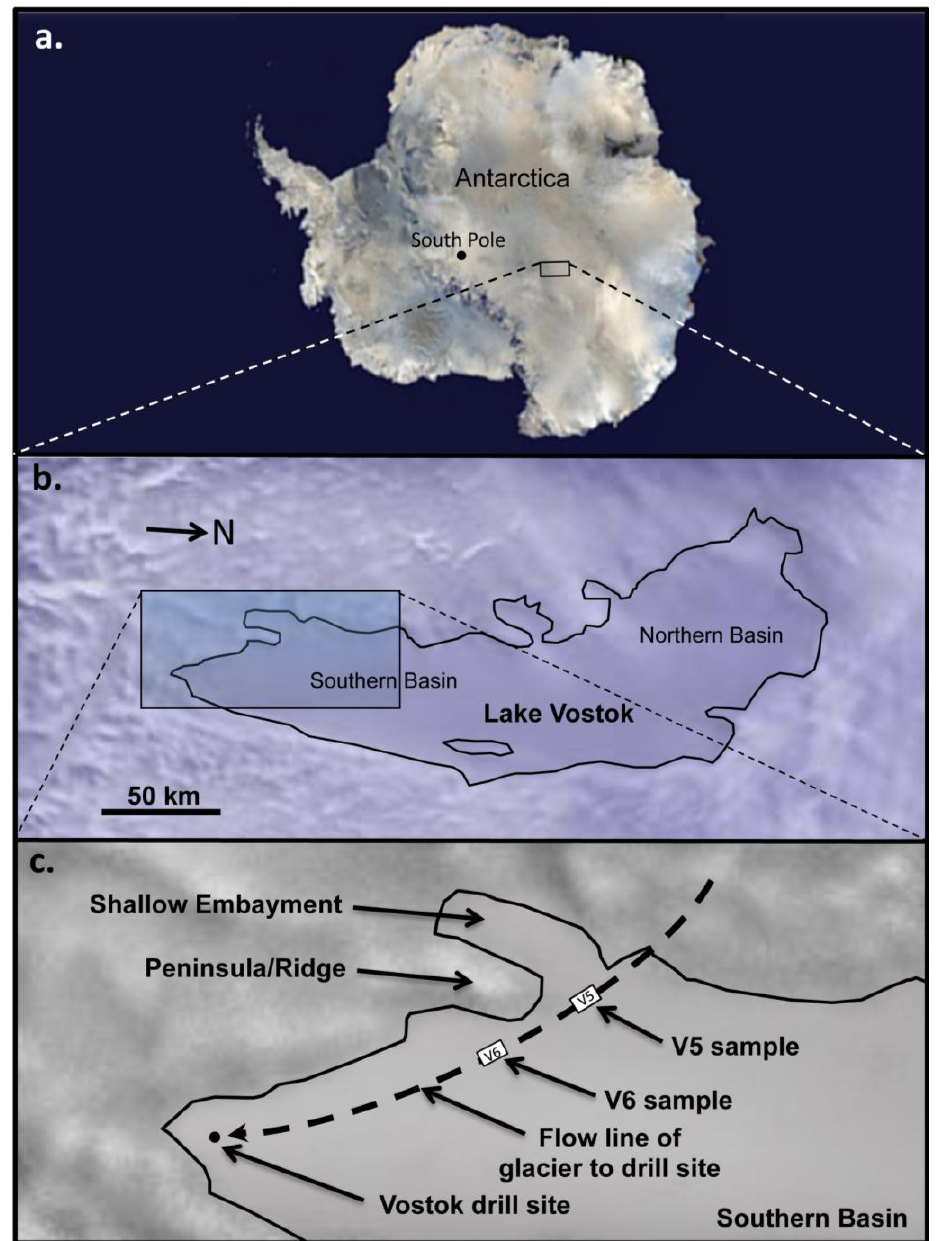
Figure 1. Source of ice core sections used in this study. ( a ) Location of Lake Vostok (small rectangle) in Antarctica; ( b ) Detail of the outline of Lake Vostok, as indicated by radar [1,8,23,24]; ( c ) Detail of the southern end of Lake Vostok, showing the locations of the shallow embayment, ridge, southern basin, track of glacier to the drill site (dashed line), and approximate locations where the accretion ice samples (V5 and V6) were